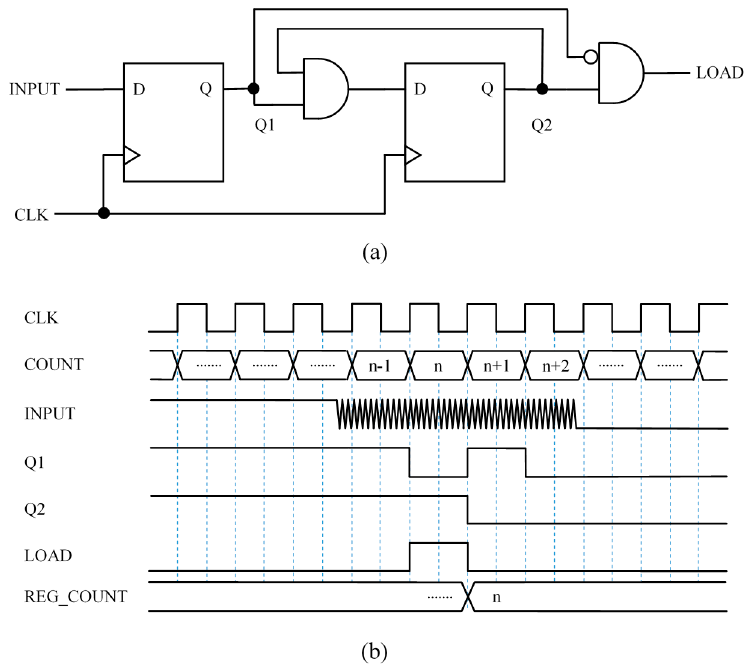
Figure 6. Capture Module 2—Synchronous circuit to signal the input fall edge with a single pulse: ( a ) circuit and ( b ) example chronogram.